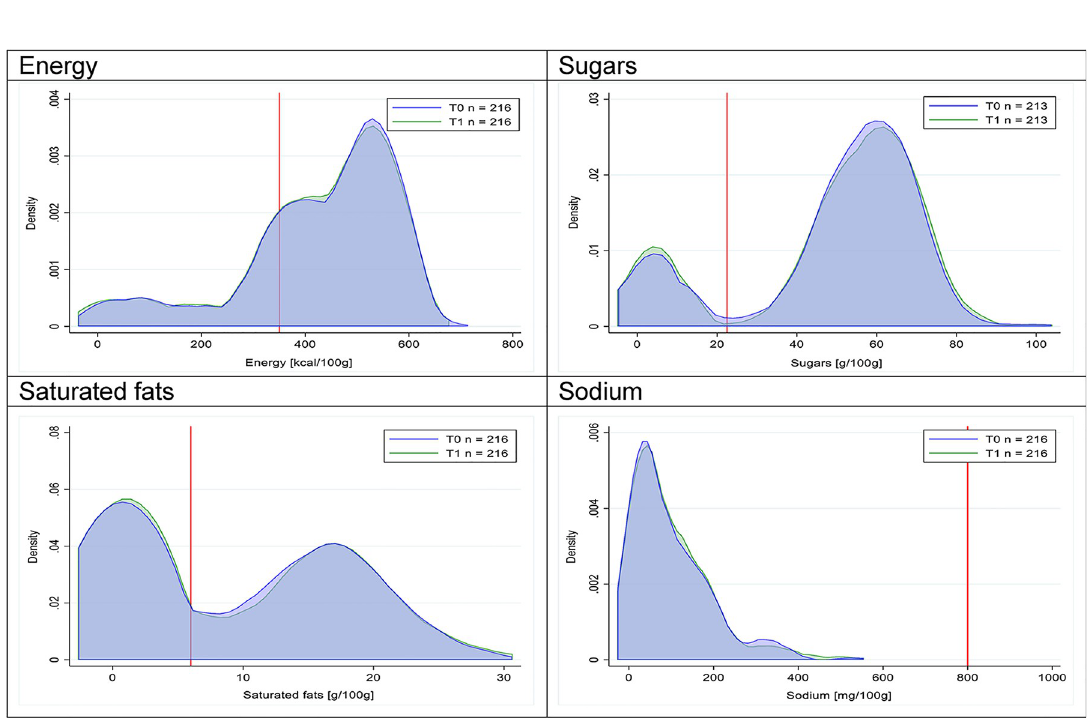
Fig 24. Density curves for the amount of energy and nutrients of concern in candies and sweet confectioneries, longitudinal subsample. The blue line represents the distribution in T0 (preimplementation), the green line represents the distribution in T1 (postimplementation), and the red line represents the cutoff for the amount of energy or nutrients of concern.